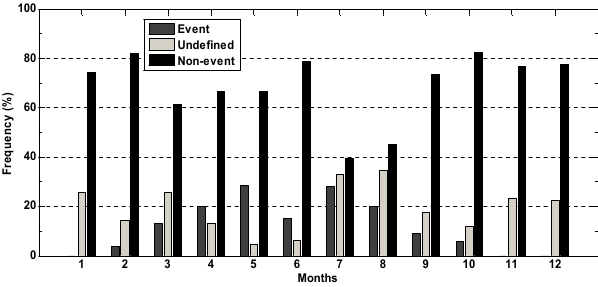
Figure 4. Monthly frequency (%) of NPF events, NPF non-events and undefined days. Data collected continuously from July 2009 to September